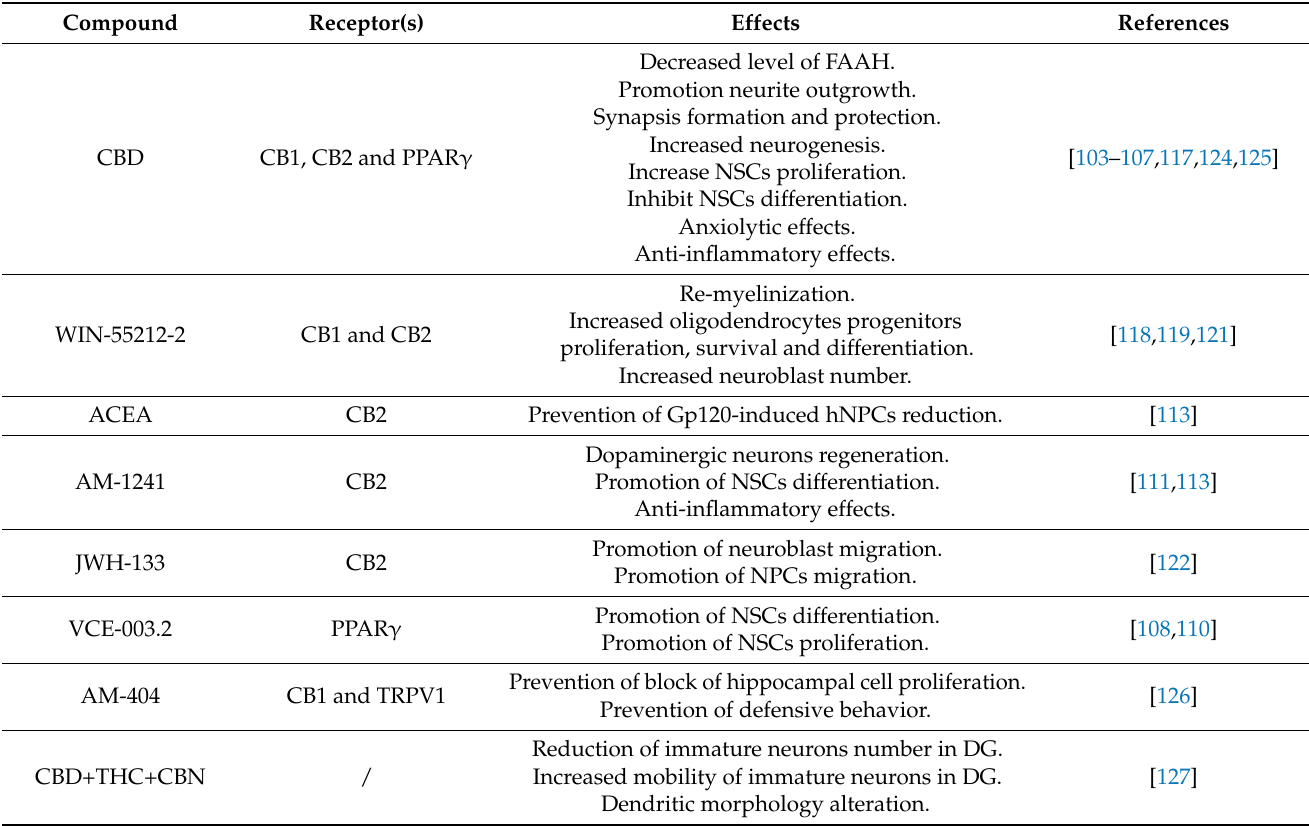
Table 3. Cannabinoids and their effect on neurogenesis in pathological models, with the receptor(s) where they are supposed to exert the effects described in the selected